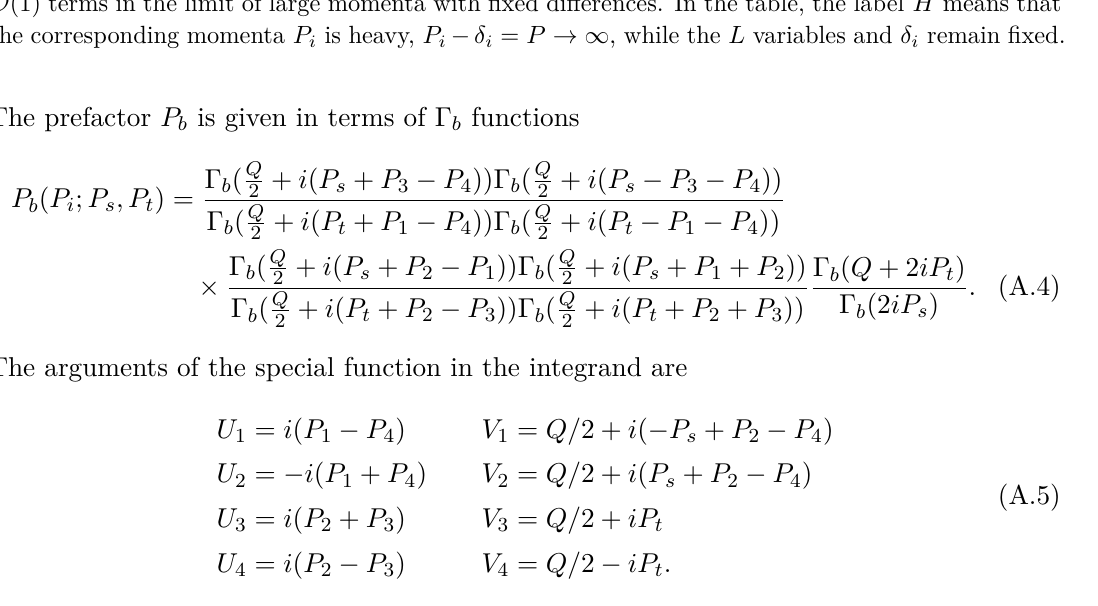
h i P 2 P 1 up to s P t P 3 P 4